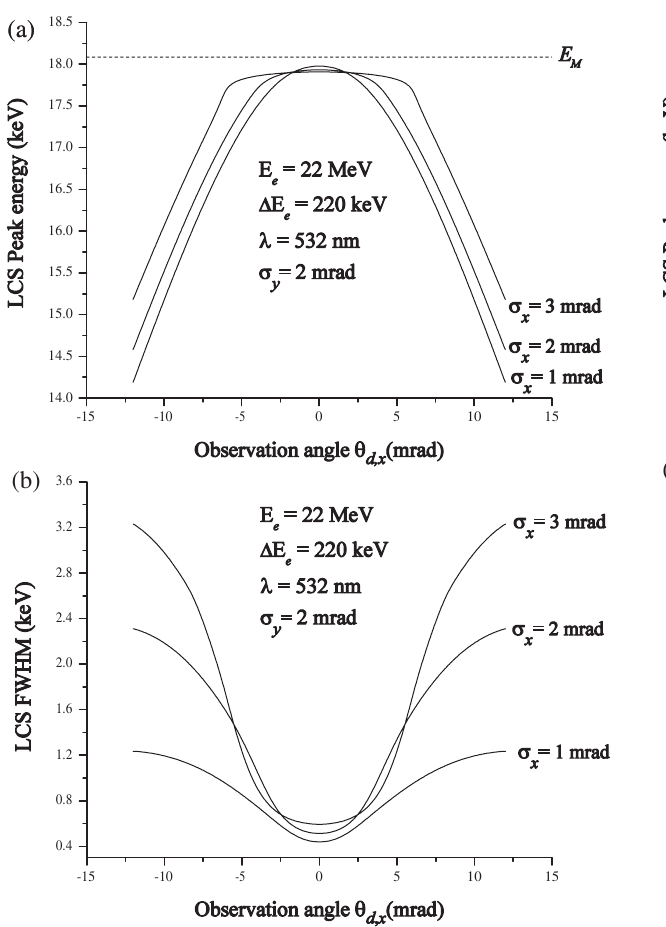
FIG. 5. Same as Figs. 4(a) and 4(b) but for different values of (cid:6) y with respect to the forward d;x . The angular scan is along x (cid:2) d;y (cid:4) (cid:6) (cid:5) = 2 , where (cid:6) and (cid:6) are 2 x; 1 x; 2 x; 1 x; 2 (cid:2) 18 : 09 keV . The curves were M